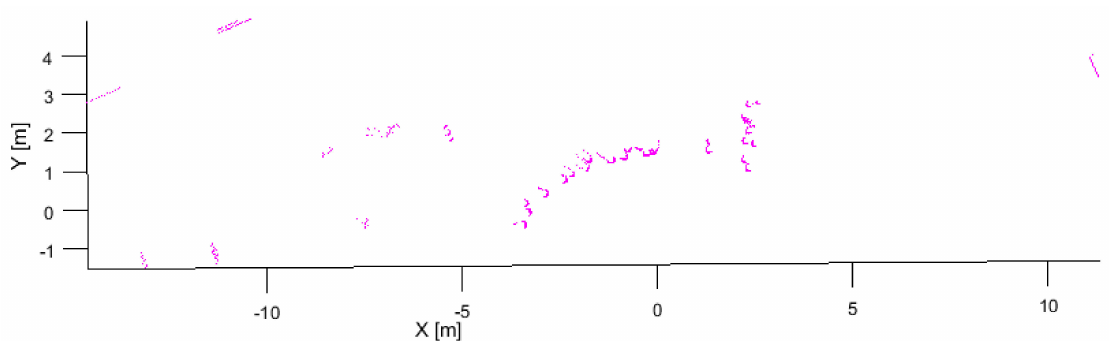
Figure 15. Identified objects at low-speed